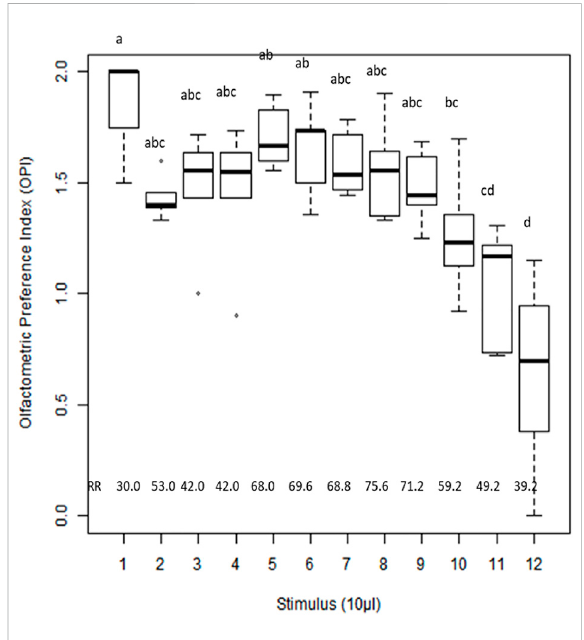
(0.05% – 1%). A signi fi cant difference in oviposition was 0.05; df = 6) (Table 2). B. tabaci laid signi fi cantly higher